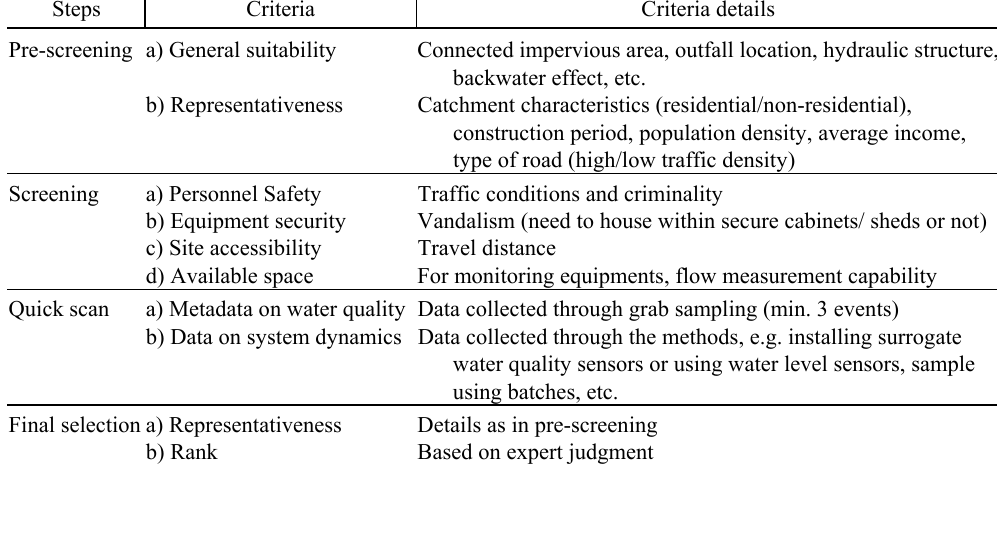
Table 1. Methodology for selection of locations